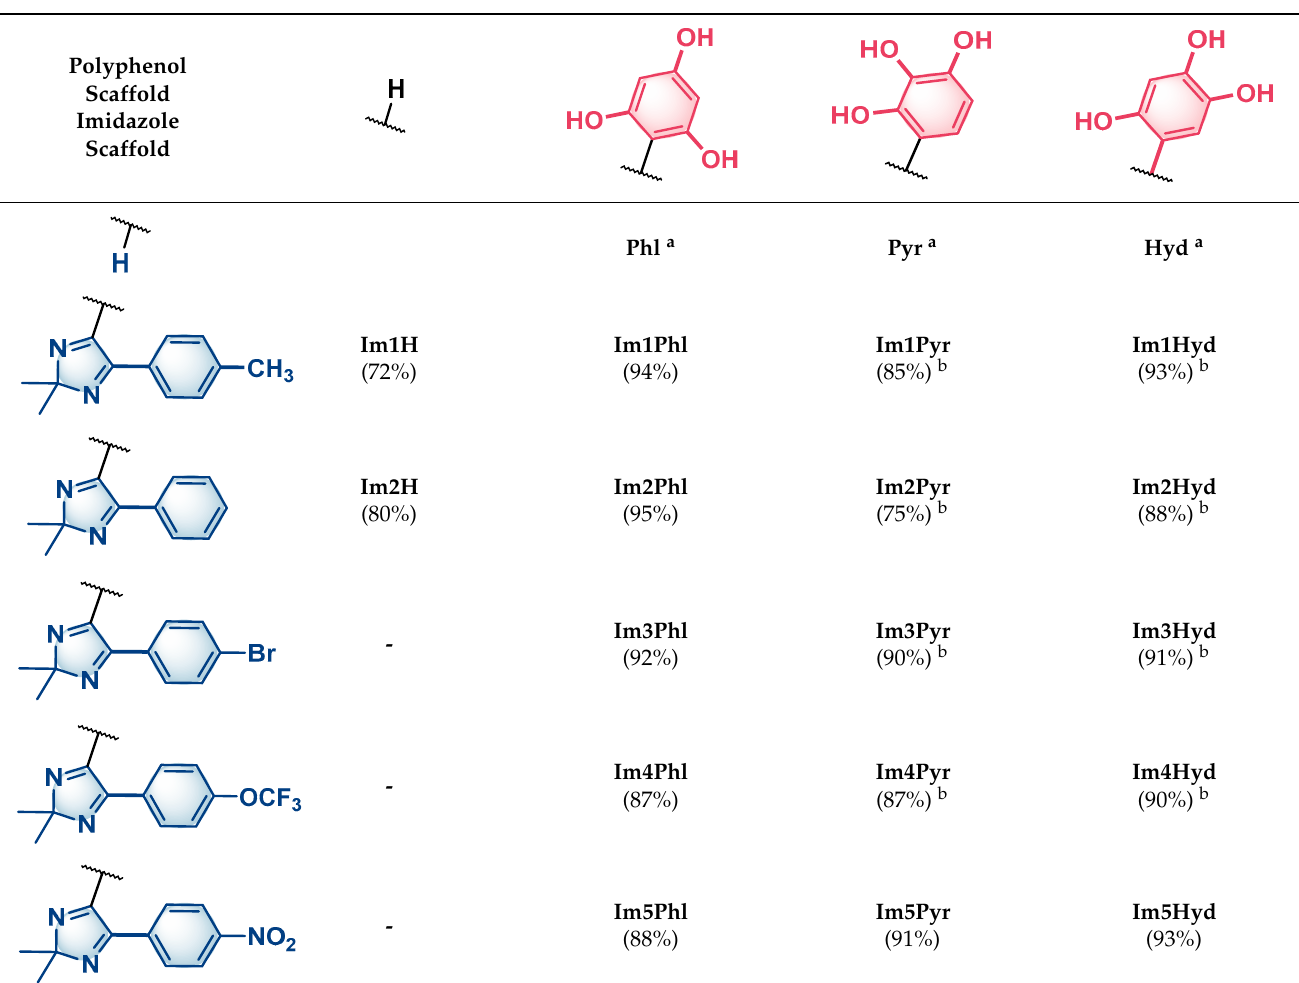
Table 1. Structures of molecular systems.